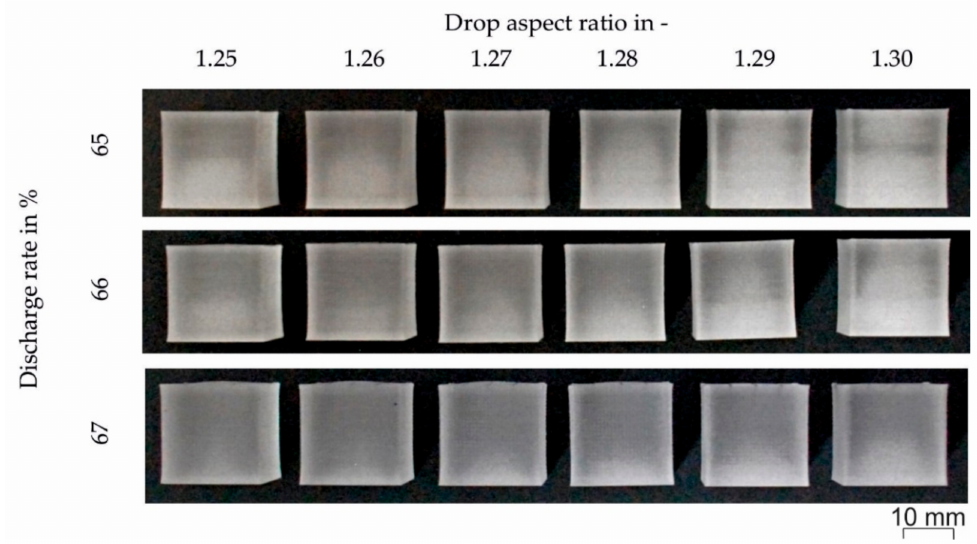
Figure 7. Cubic specimens printed at di ff erent discharge rates (65, 66 and 67%) and drop aspect ratios between 1.25 and 1.30. Other processing temperatures were T 1 = 200 ◦ C, T 2 = 230 ◦ C, T nozzle = 245 ◦ C, and T chamber = 100 ◦ C.